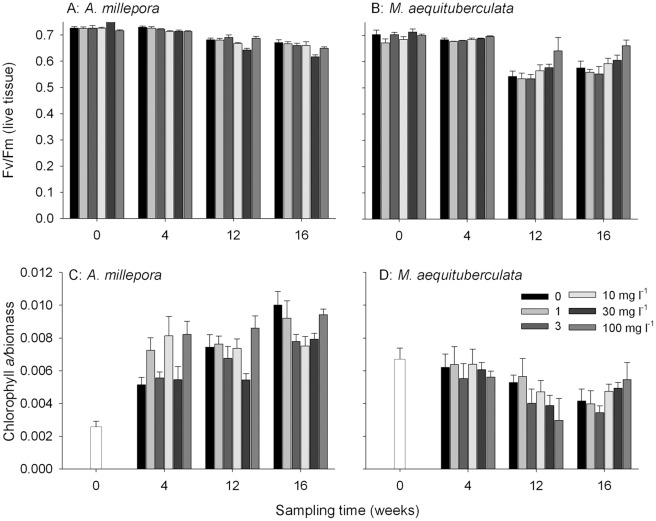
Mean maximum potential quantum yields (Fv/Fm) (+ SE, n = 9) for (A) A. millepora and (B) M. aequituberculata for each of the sediment treatments over the 16 week experiment.Chlorophyll a concentration normalized to biomass at each of the sampling periods for (C) A. millepora and (D) M. aequituberculata (bars + SE, n = 9 corals per treatment per sampling period). Nine corals were collected at t = 0 days to represent all of the initial treatments.